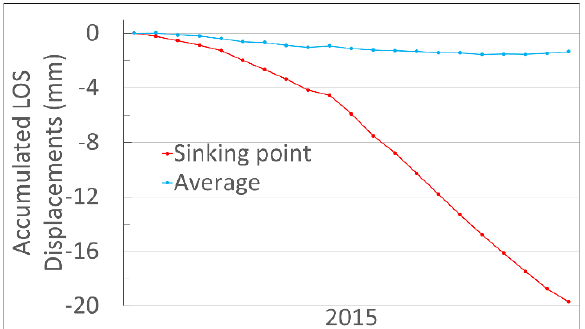
Figure 12. Displacement sequences of sinking point (red) and average (blue) (Figure 11). Similarity between two sequences: Euclidean distance, 36.4 mm; Manhattan distance, 124.7 mm; Chebyshev distance, 16.1 mm.